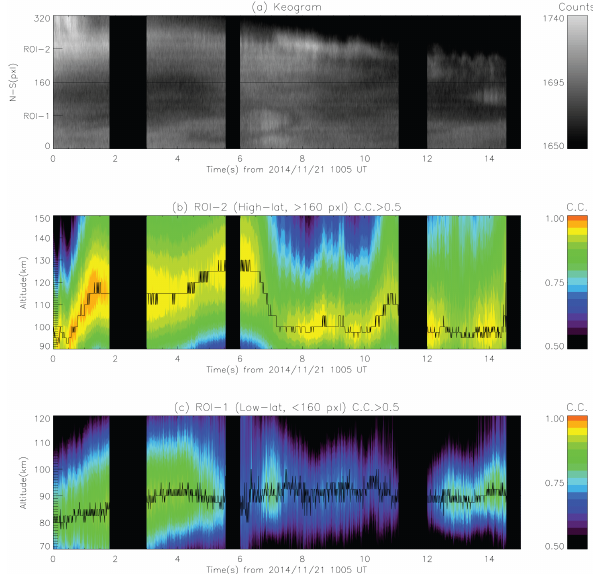
Figure 3. Time variation of the (a) auroral intensity and of (b, c) cross-correlation coefficient at each emission altitude. Top panel shows the north–south keogram across the center of star- removed images at PFRR, where grayscale shows the linearly in- creasing auroral intensity in arbitrary units. Middle and bottom pan- els show the altitude variations of aurora at high-latitude part ROI- 1 and low-latitude part ROI-2, respectively where blue to red col- ors show the linearly increasing cross-correlation coefficient (C.C.) from 0.5 to 1.0. The altitudes of peak C.C. values are marked by black